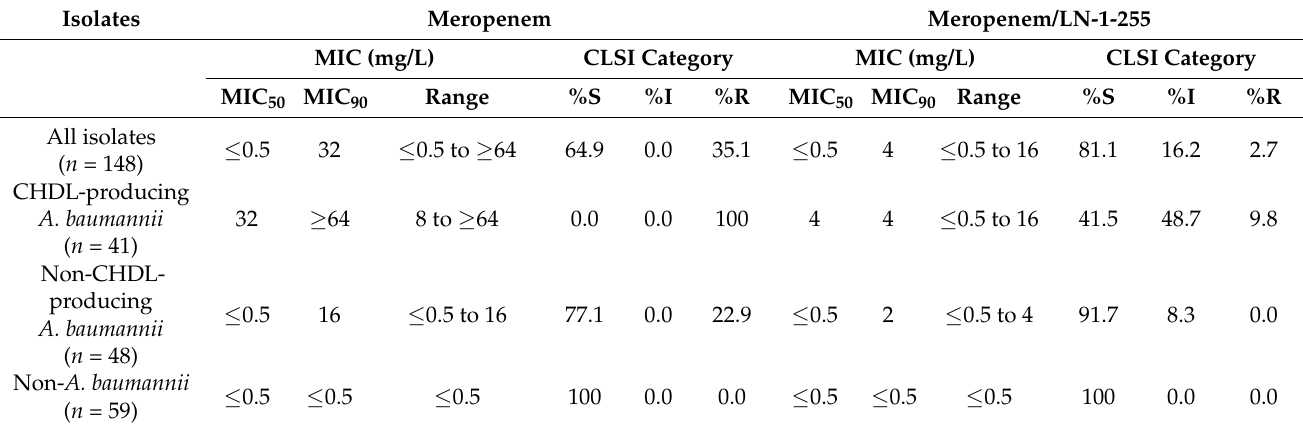
Table 2. Susceptibility of Acinetobacter spp. isolates to meropenem and